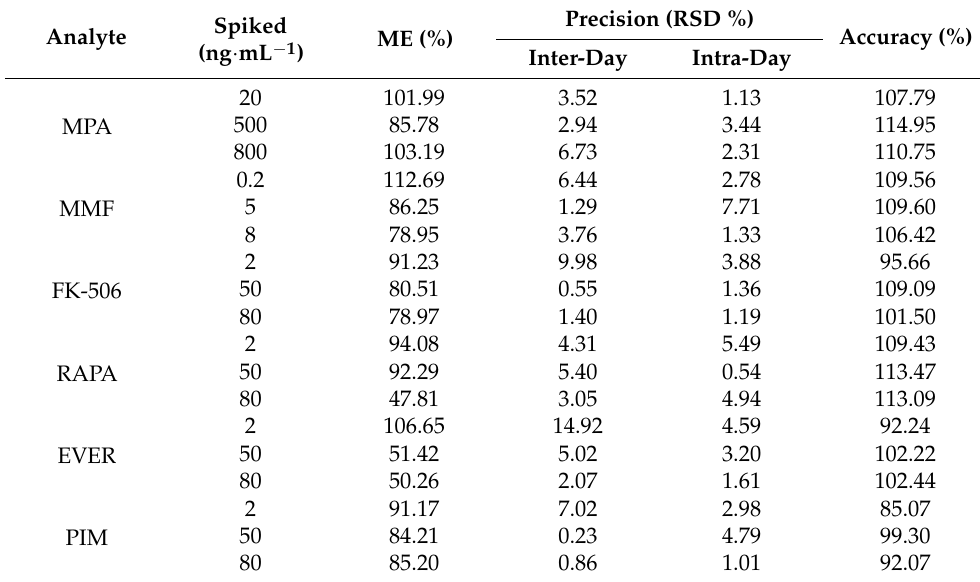
Table 1. Intra-day and inter-day precision and ME of analytes ( n = 3).